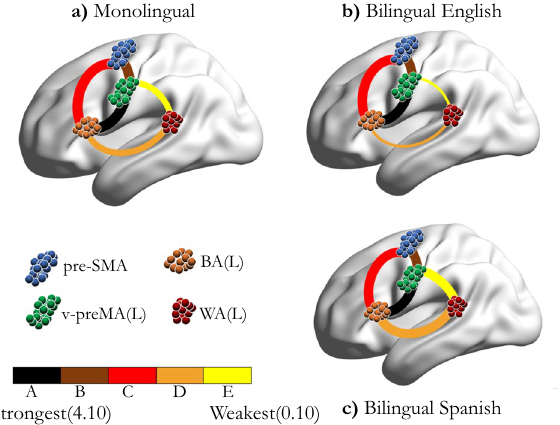
Figure 4. Common network visualization. Visualization of the shared common network across subjects in ( a ) monolingual group, ( b ) bilingual English-speaking group and in ( c ) bilingual Spanish-speaking group, constructed by the methods described in “Common network construction across subjects” section. Here, we show the sagittal view of the left brain. The modules color legend is provided below panel ( a ). The link colors represent the W C ij hierarchy strengths within each group. The link color bar is provided below the color legends of the modules. From Left to Right, we show the strongest (the largest W C ij ) to the weakest (the smallest W C ij ). The links between each fROI pairs are abbreviated as A-E, see Supplementary Tables S5–S7 for more details. The thickness of the links represents how frequently (in how many subjects) they appear. WA connects with preMA(L) and BA(L) in 75% of monolingual subjects, 50% of bilingual English-speaking subjects and 100% of bilingual Spanish-speaking subjects, respectively. The background brain surface was created in BrainNet Viewer 34